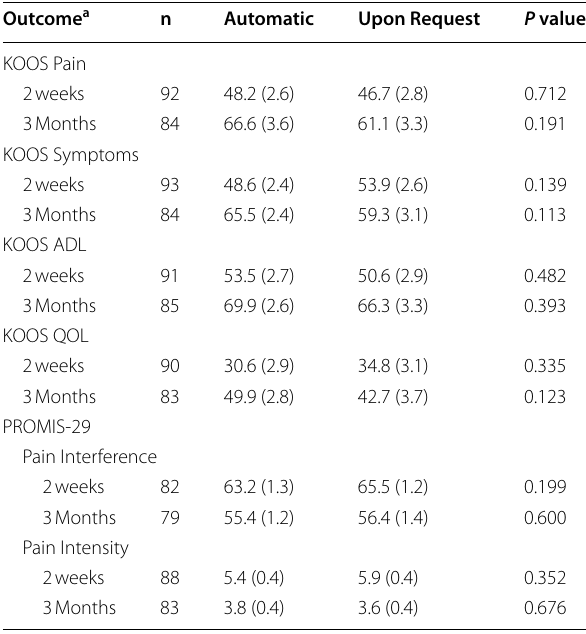
Table 3 Patient-reported Outcomes at 2 Weeks and 3 Months After TKA by Treatment